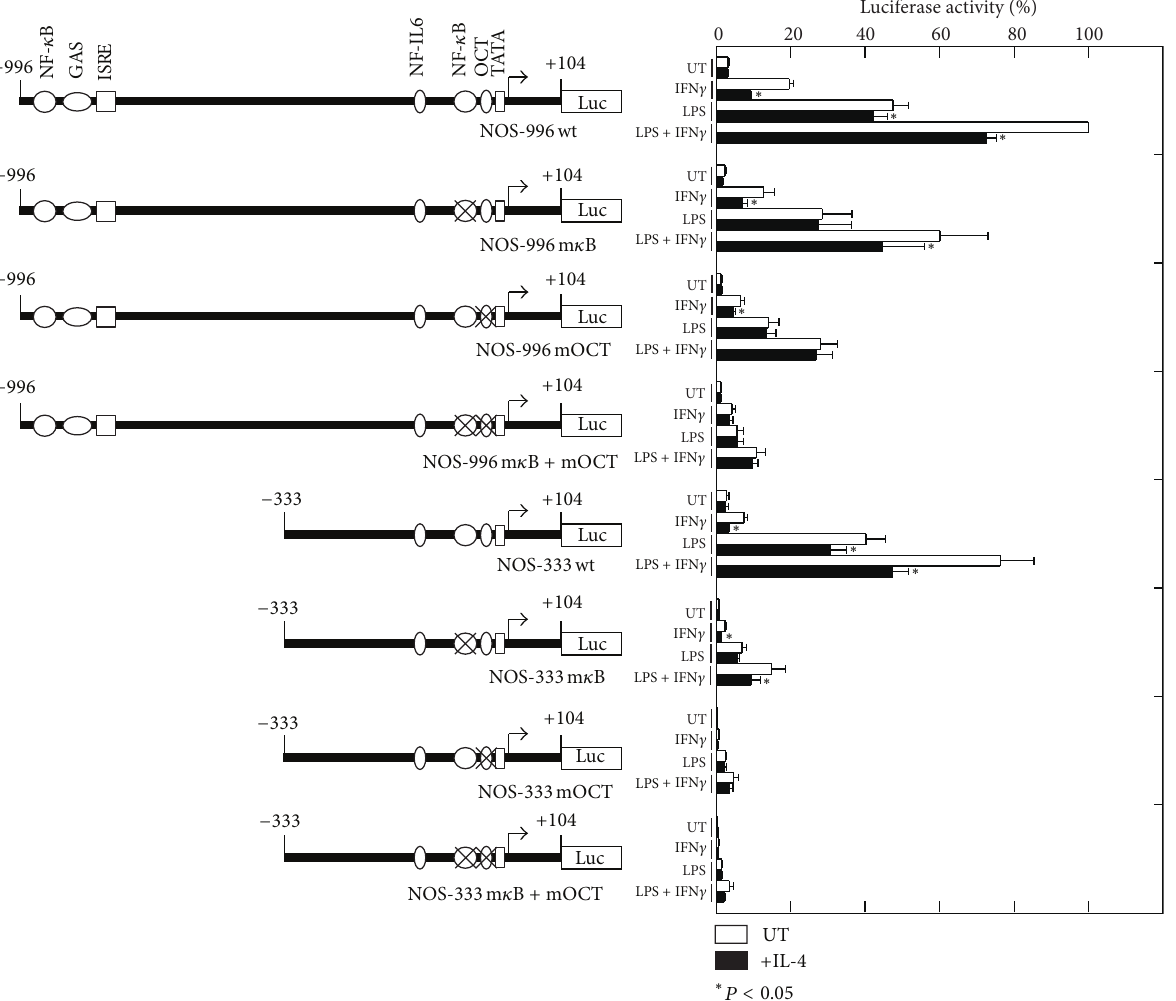
Figure 4: Mutational analysis of the mouse Nos2 enhancer/promoter region by luciferase reporter assays in RAW264.7 cells. The diagram on the left shows the wild-type (pNOS-996 and pNOS-333) and mutant Nos2 luciferase reporter constructs. Mutations of the NF- 𝜅 B and/or OCT sites in the constructs are also indicated. RAW264.7 cells were transiently transfected with the wild-type or the mutant Nos2 luciferase reporter construct, as described above. The relative luciferase activities are shown as percentages of the activity in cells transfected with the wild-type construct (pNOS-996) and stimulated with IFN 𝛾 and LPS. Each column and bar represents the mean ± SEM of three independent experiments. The asterisks denote a statistically significant difference compared to the cultures treated with IL-4 ( 𝑃 < 0.05 , Student’s 𝑡